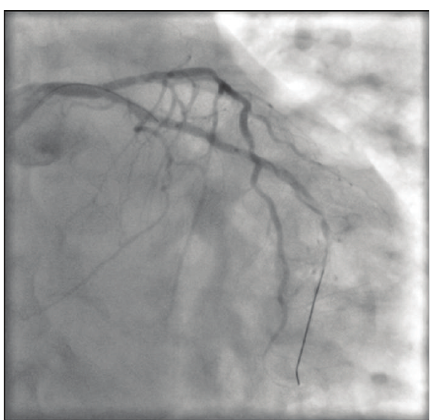
Figure 4: Type B dissection of proximal